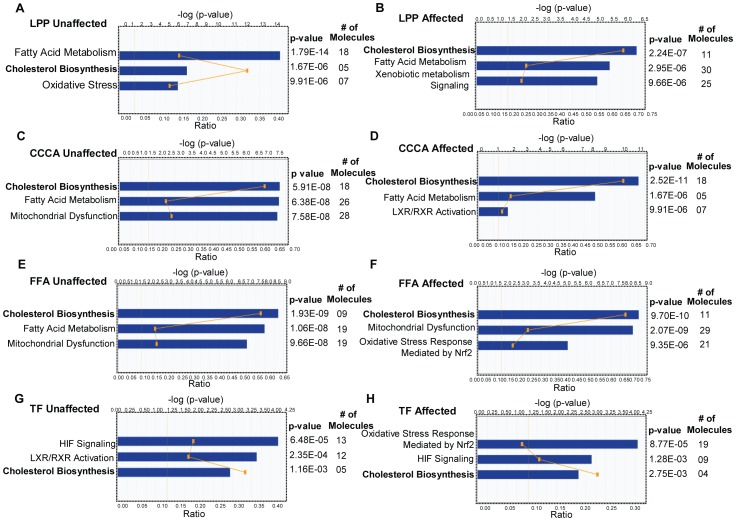
Ingenuity Pathways Analysis of the top toxic pathways in cicatricial alopecia.IPA-Tox®, a data analysis capability tool within the Ingenuity Pathways Analysis, was used to analyze the microarray data and to determine the toxicity associated with the observed gene expression changes in PCA. The figure shows the top toxicity lists (Toxlists) associated with gene expression changes in samples from unaffected and affected scalp areas in patients with LPP, CCCA, FFA and TF. Cholesterol biosynthesis appears to be the most significant toxicity-related pathway associated with the lymphocytic PCA subtypes.